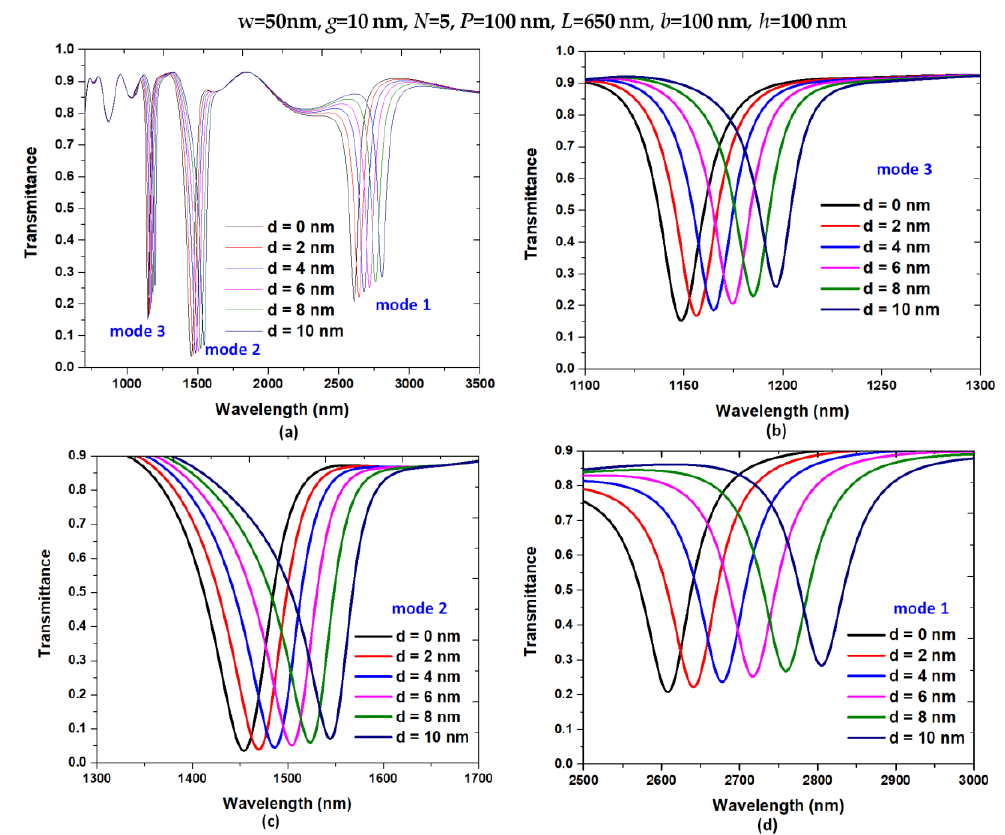
Figure 4. Transmittance spectra of the designed structure with a variation of d from 0 to 10 nm with an interval of 2 nm in the wavelength of ( a ) 700–3500 nm for modes 1–3, ( b ) 1100–1300 nm for mode 3, ( c ) 1300–1700 nm for mode 2, and ( d ) 2500–3000 nm for mode 1, respectively.